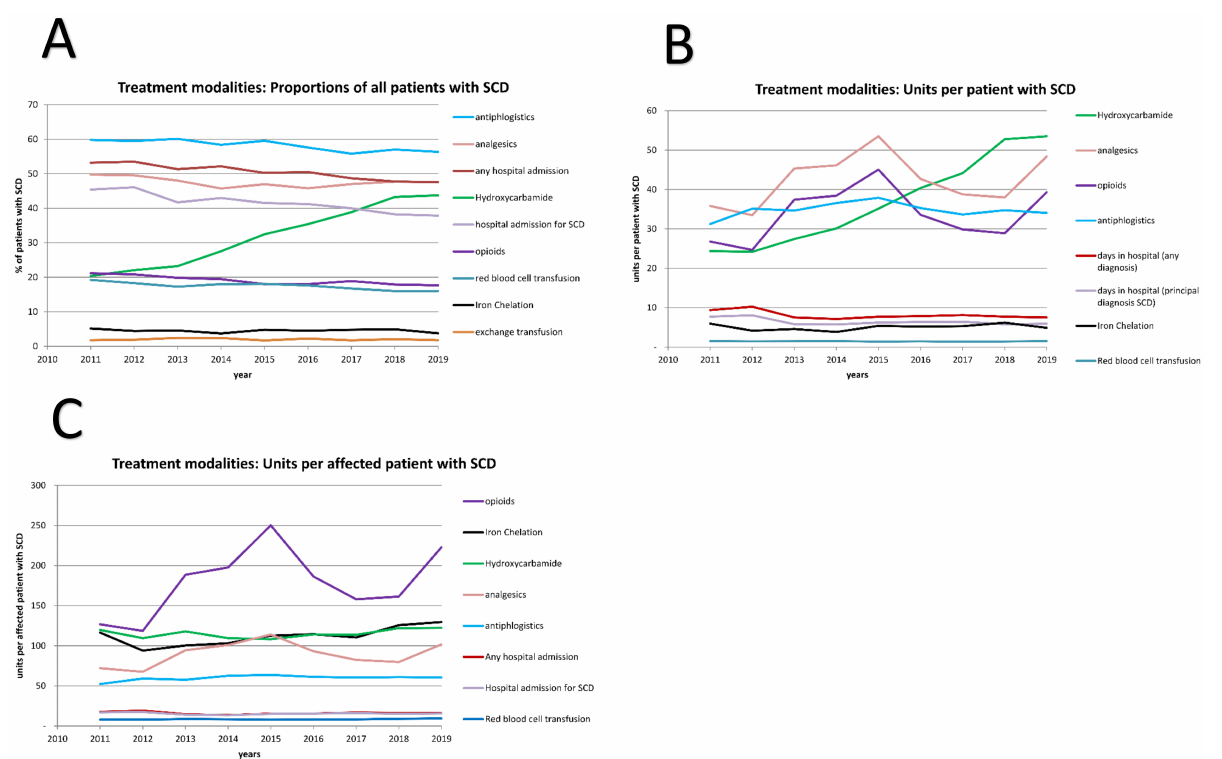
Figure 3. Treatment modalities administered in SCD patients. ( A ) The proportion of all patients with SCD for whom at least one hospital admission, one hospital admission with a diagnosis D57.0/1/2, red blood cell transfusions (OPS 8-800.c), iron chelation (ATC V03AC), or exchange transfusion (OPS 8-801), prescription of hydroxyurea (ATC L01XX05), anti-inflammatory and antirheumatic drug (M01), analgesics (N02) or opioids (N02A) per year was documented. ( B ) The different treatment modalities are quantified per patient with SCD as defined daily doses (DDD) for hydroxyurea, analgesics (M01, N02, N02A) and antichelating agents; for red blood cell transfusion, the number of red blood cell units transfused during an inpatient treatment and for hospital admissions, days in hospital were counted. The sum of these measures for all patients with SCD was divided by the number of patients with SCD. ( C ) As in ( B ), but the denominator was the number of patients with SCD that had at least one prescription of the treatment of interest. In order to account for the changing distribution of age and sex, patient numbers were normalized to the German population in